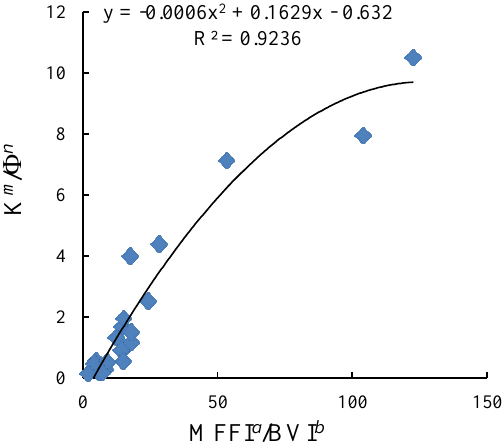
Figure 7. The cross-plot between the ratio of movable pore volume to irreducible pore volume and RQI. a = 1.82; b = 0.9; m = 1.02; n =